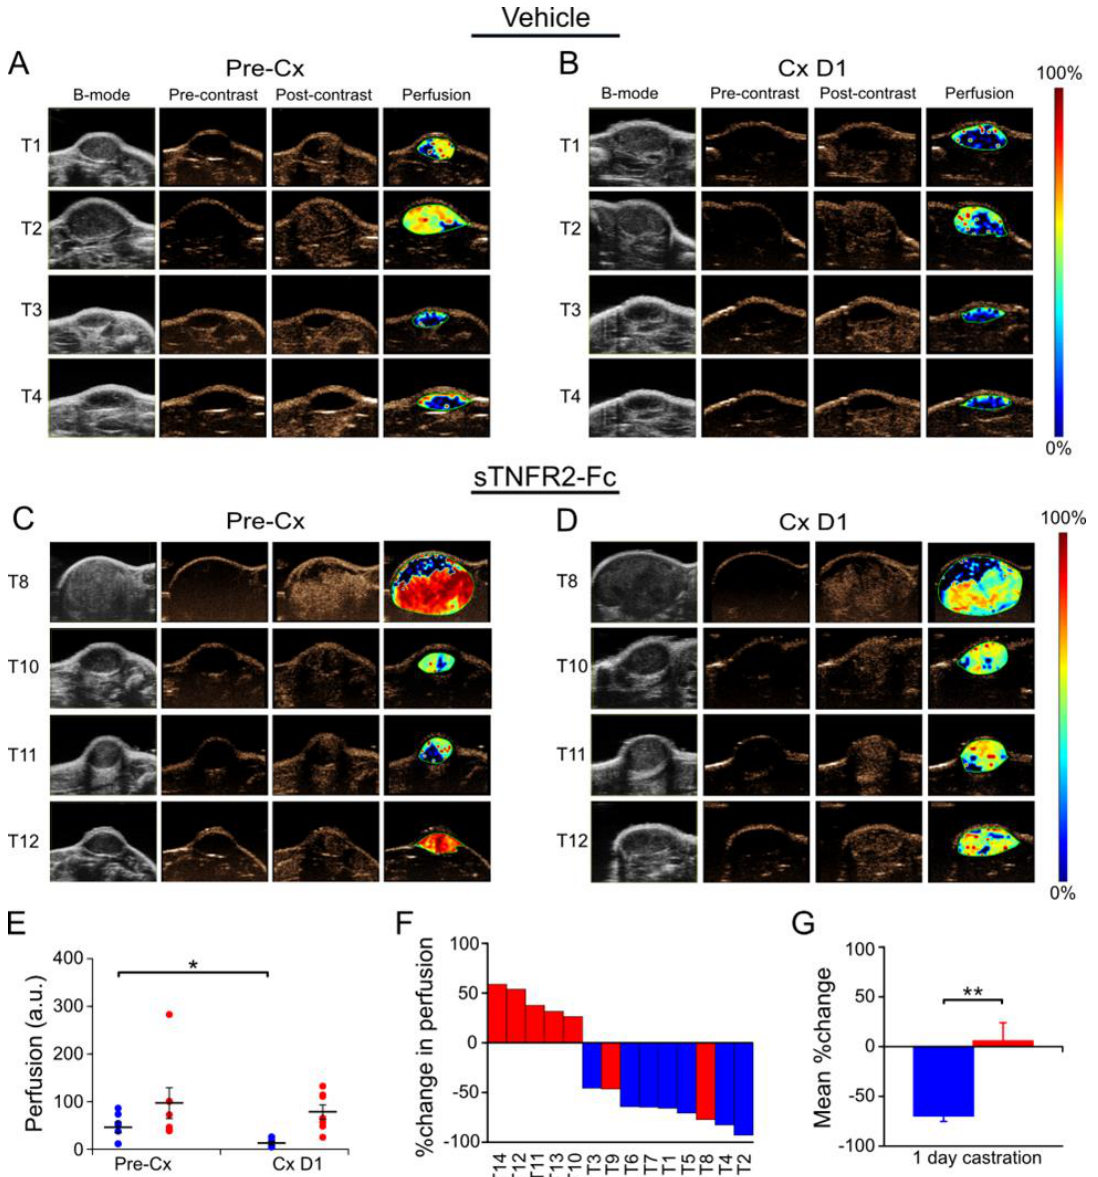
Figure 3. TNF signaling is necessary for castration-induced reduction of perfusion in Myc-CaP tumor. ( A ) Contrast-enhanced ultrasound (CE-US) images of subcutaneous Myc-CaP tumors pre- castration (Pre-Cx) of mice treated with PBS (Vehicle), tumors 1–4 (of 7 evaluable tumors) are shown. Left to right: Gray-scale ultrasound image (B-mode); contrast-mode image prior to contrast agent injection (Pre-contrast); contrast-mode image after injection at the peak enhancement of contrast (Post-contrast); pseudo-colored image of the change in contrast enhancement (Perfusion). ( B ) CE-US images of tumors 1–4 in panel A after one day castration (Cx D1). ( C ) CE-US images of a second set of subcutaneous Myc-CaP tumors pre-castration of mice treated with sTNFR2-Fc, tumors 8, 10, 11, 12 (of 7 evaluable tumors) are shown. ( D ) CE-US images of tumors in panel C, one day after castration, ( E ) Mean perfusion (large bars) pre-castration and post-castration in tumors in vehicle- treated (blue) and sTNFR2-Fc-treated (red) mice, perfusion signal of each tumor indicated by closed circles. ( F ) Waterfall plot of %change in perfusion in individual tumors (columns). ( G ) Average % change in perfusion pre-castration and post-castration. ( E , G ): Columns and large bars are means and small bars are SEM. * p < 0.05, ** p <